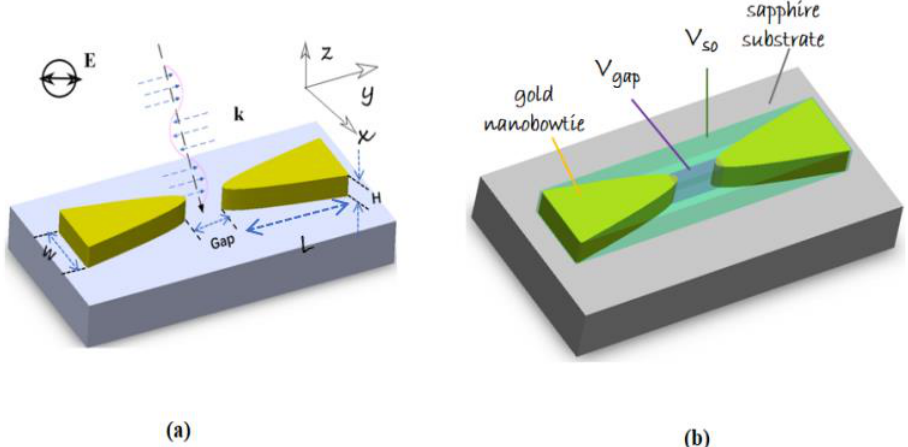
Figure 1. Schematic view of the simulation object. The simulation model consisted of a PGNB made of gold and a sapphire substrate on which the PGNB was standing on. ( a ) A Cartesian coordinate system was used for the simulation, in which the center of the gap for the nanobowtie was selected to locate the origin of the coordinates, and the center line of the PGNB was oriented at the y -axis. The forward direction of the z -axis was bottom-up-oriented and vertical to the surface of the sapphire substrate. A linear, polarized source (a TFSF source consisting of a series of plane waves) with a broad wavelength range was illuminated on the PGNB perpendicularly with a specific polarization angle. ( b ) The green box shows the integration volume ( V so ) for calculating the average field enhancement factor over the simulation object and also the volume for calculating the light-wave-absorption power of the PGNB. The violet box shows the integration volume ( V gap ) for calculating the average field enhancement factor over the